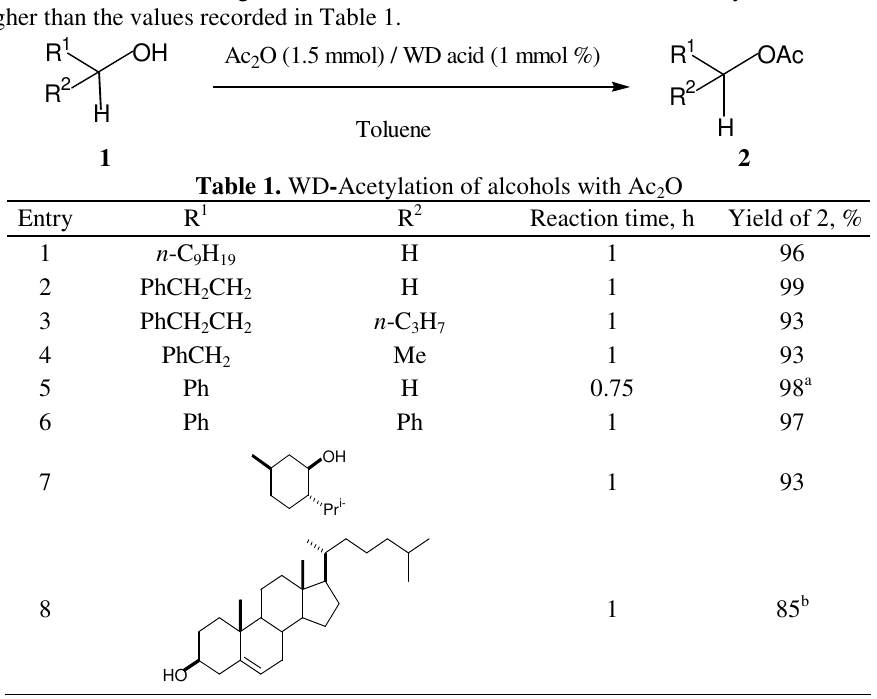
Table 1. WD - Acetylation of alcohols with Ac